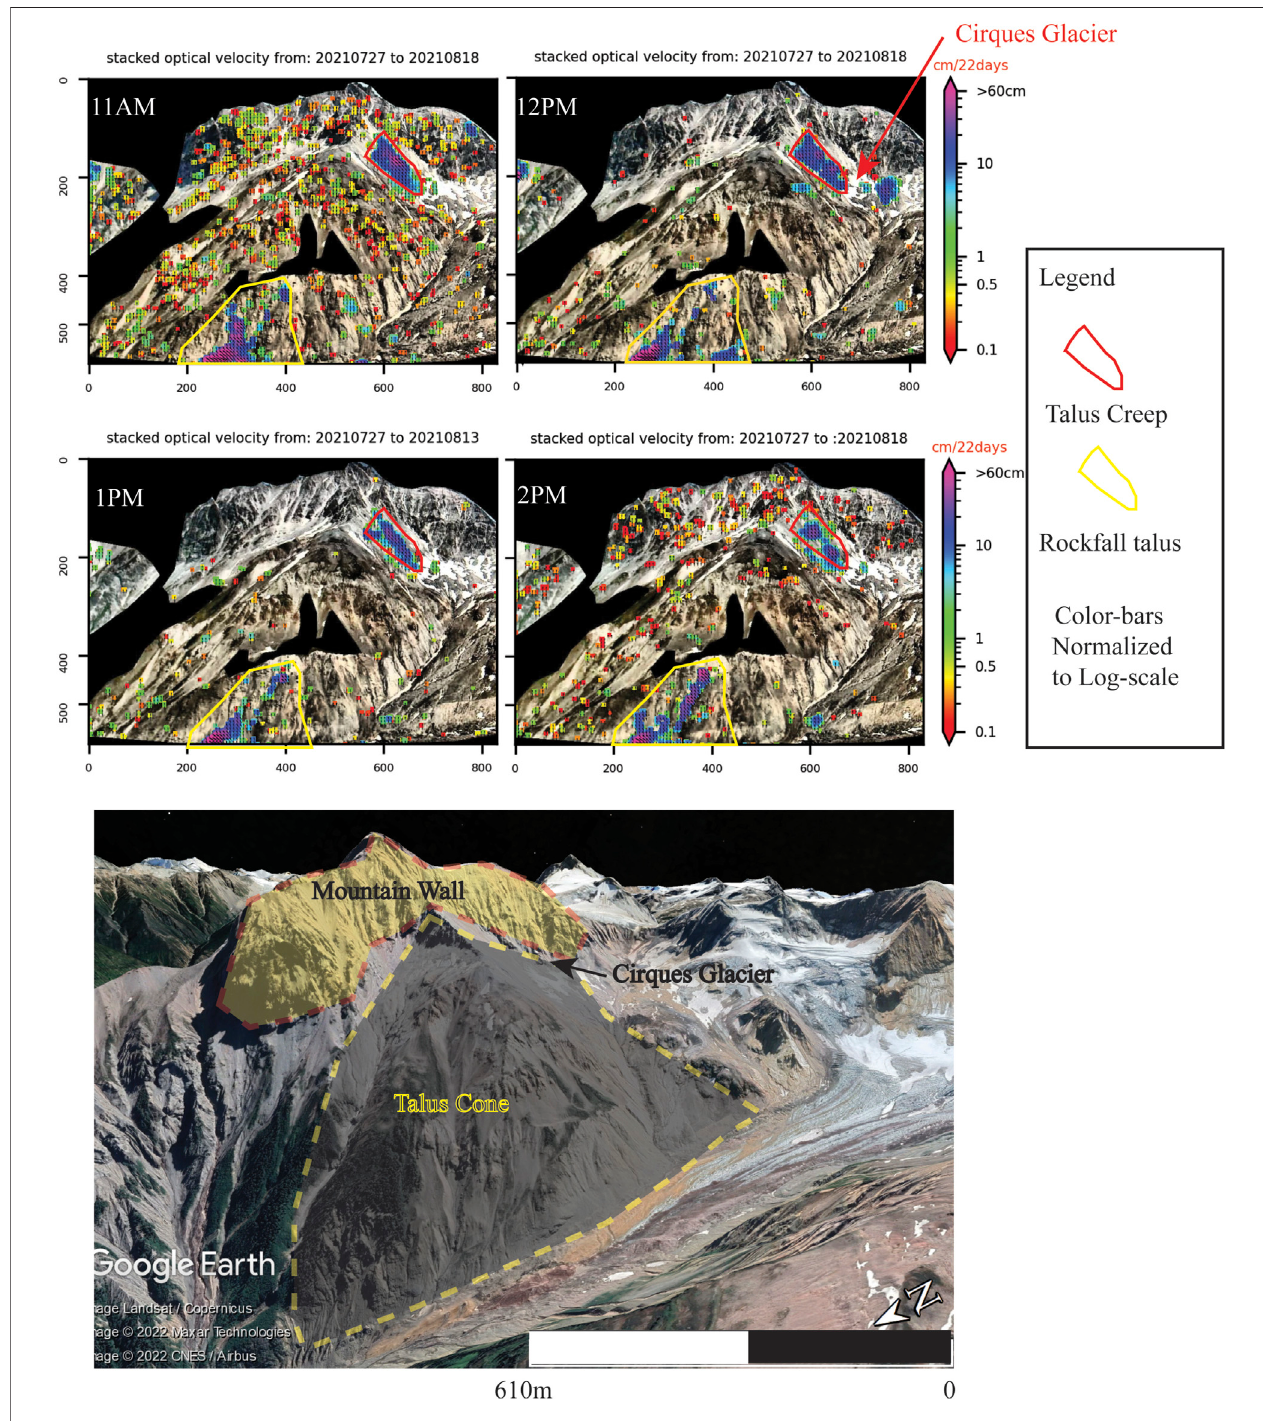
FIGURE 11 | Average displacement rate and average magnitude velocity of rockfalls calculated from a stack of processed image triplets for four different times of the day for the Plinth Peak slope. Note that the rockfall region areas show average magnitude velocity of rockfalls ranging between 20 and 60 cm.